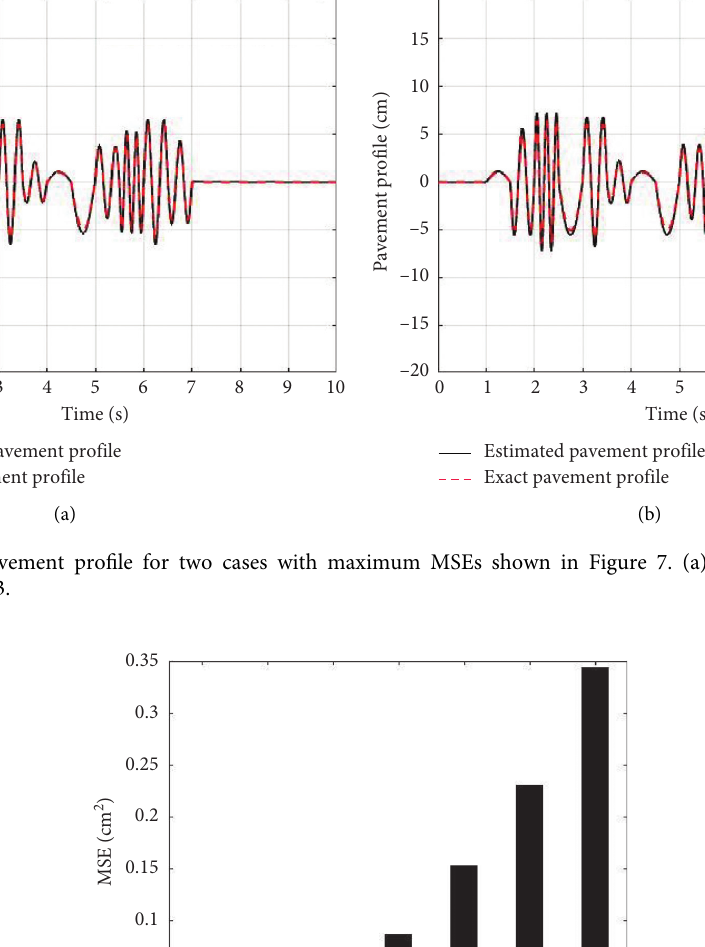
Figure 9: The pavement profile estimation error for different speed values.